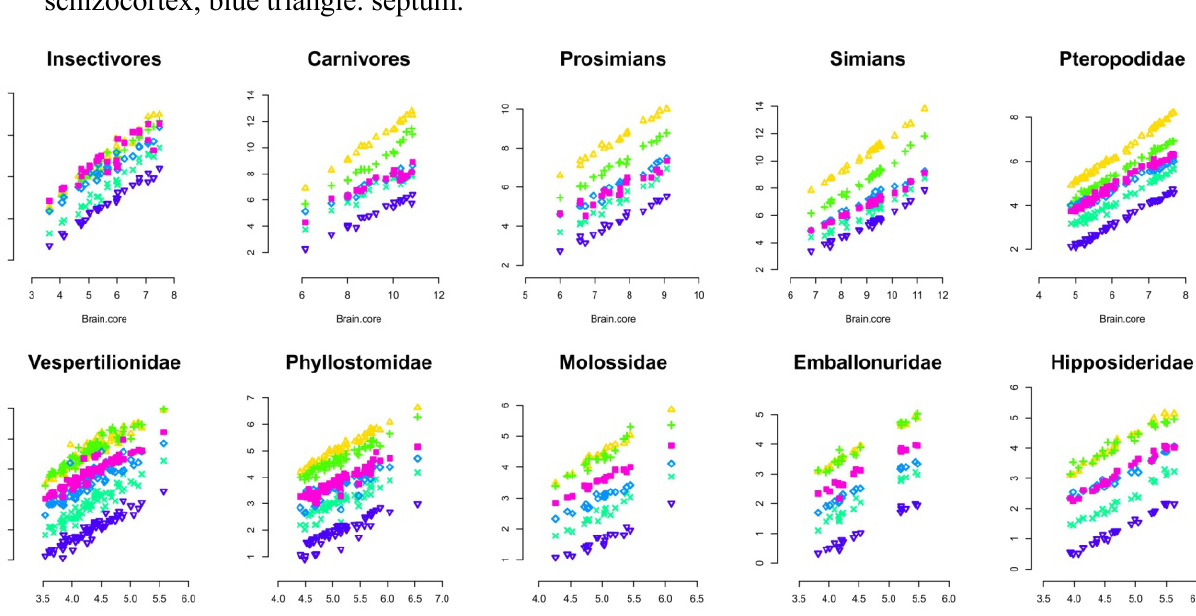
Figure 1. Regression of brain structure sizes onto brain core size (log scale). Taxonomic levels differ among taxa. Prosimians and simians (primates) are represented separately